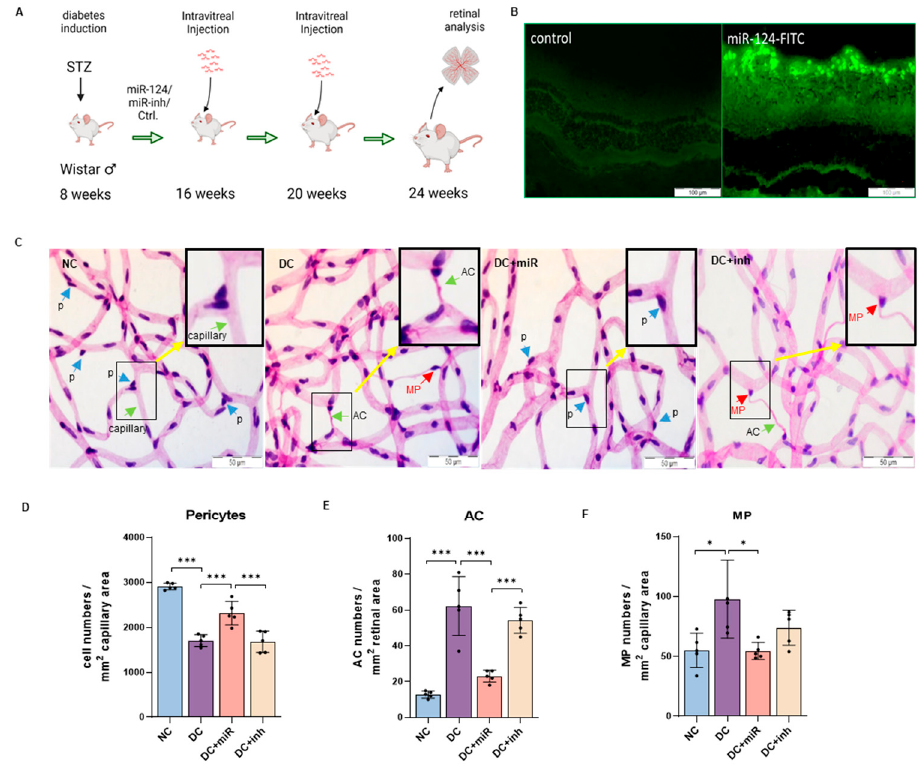
Figure 1. Effects of miR-124 on pericyte loss and AC formation in diabetic rat retinae. ( A ) Schema of animal experiments. According to the diabetes-induction and miR-124 injection, the animals are divided into four groups: non-diabetic control (NC), diabetes (DC), diabetes treated with miR-124 (DC+miR), or diabetes treated with miR-124 inhibitor (DC+inh). ( B ) Images of green fluorescence from the eyes injected with 25 pmol of miR-124-FITC (right) or with solvent as control (left) after 3 h. Images were taken with Olympus BX51 microscope, scale bar = 100 µ m. ( C ) Representative images of PAS and hematoxylin-stained retinal digestion preparation of rats from control and experimental groups. Images were taken with Olympus BX51 microscope. AC: acellular capillary, MP: migrating pericyte, p: pericyte; scale bar = 50 µ m. ( D – F ) Quantification of pericytes (number of pericytes/mm 2 capillary area) ( D ); of acellular capillaries (number of AC/mm 2 retinal area) ( E ); of migrating pericytes (number of MP/mm 2 capillary area) ( F ) were analyzed using Cell F software version 5.1 from Olympus. n = 5, * p < 0.05, *** p < 0.001 (one-way ANOVA with Tukey’s multiple comparisons